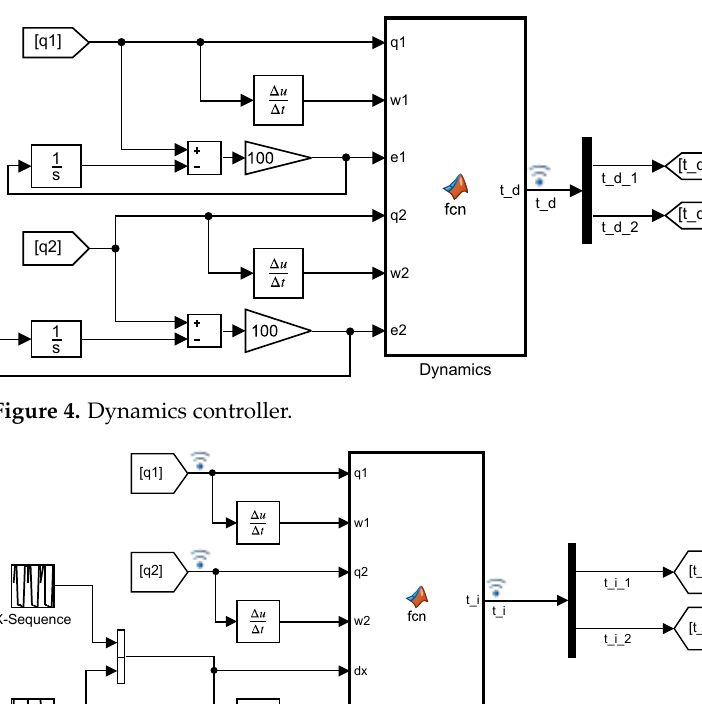
Figure 3. Robot mechanical part.